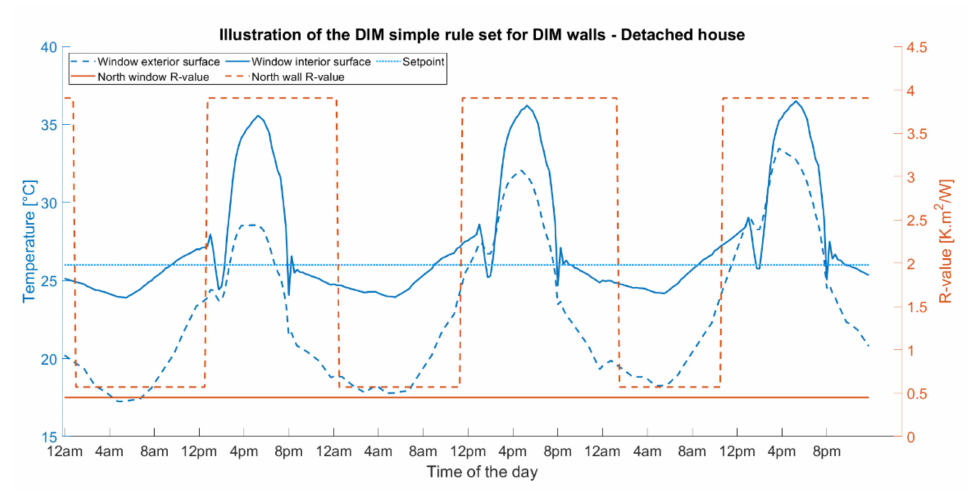
Figure 11. Performance of SIS walls only case during the period between 22 July to 24 July for the prototypical detached house located in Barcelona, Spain. For SIS walls and dynamic windows, high R-value = 3.9 m 2 · K/W; low R-value = 0.49 m 2 · K/W. For SIS windows, high R-value = 1.1 m 2 · K/W;